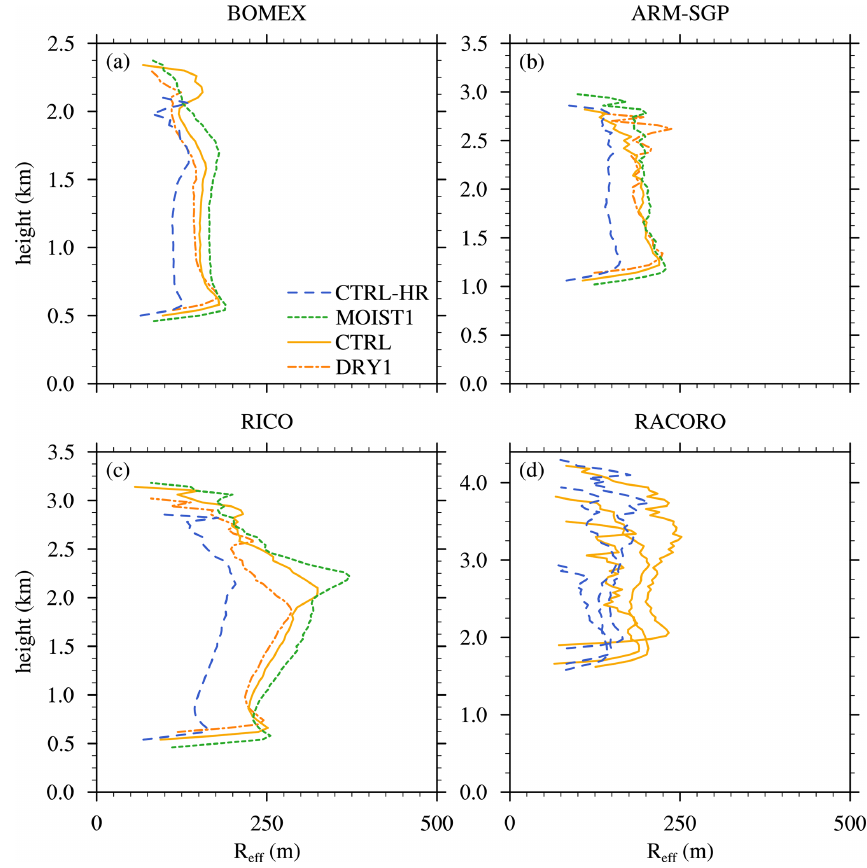
Figure 16. The effective cloud radius ( R eff ) for maritime and continental experiments: (a) BOMEX, (b) ARM-SGP, (c) RICO, and (d) RACORO. For RACORO each of the three days counts as a separate case.